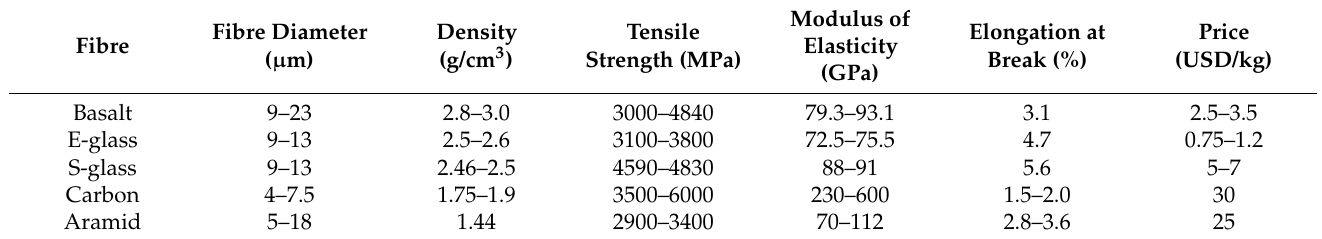
Table 1. Comparison of properties of fibres commonly used in fibre reinforced polymer composites